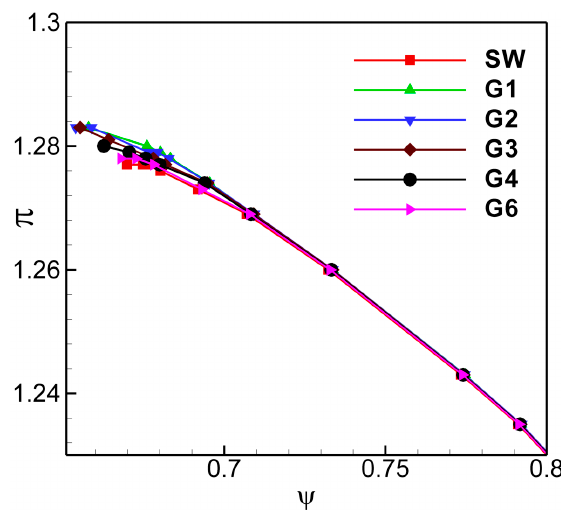
Figure 6. Overall characteristic plot of the CRAC for the SW case and different groove locations.